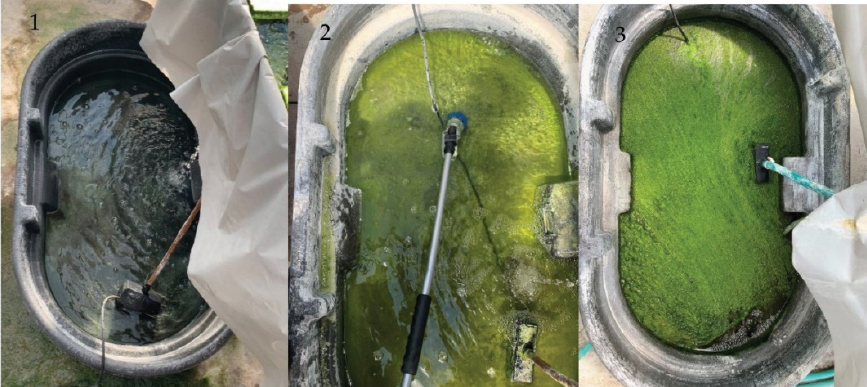
Figure 1. The visual scale of algae in tanks of ebb and flow hydroponic systems at OSU research greenhouses in Stillwater, OK. ( 1 ) = little to no algae, ( 2 ) = some algae collected on sides and bottom, ( 3 ) = thick algae matt.